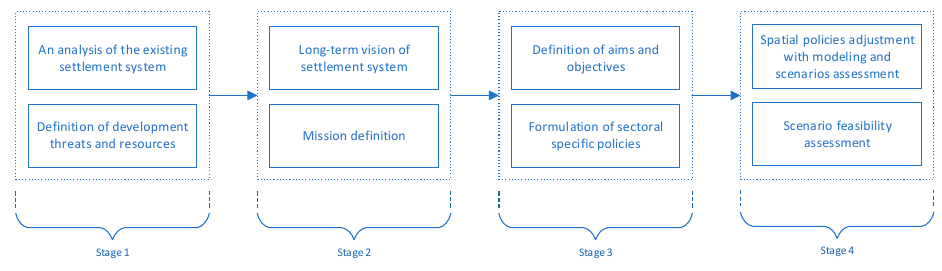
Figure 2. The algorithm of the research methodology. Source: Own Work.